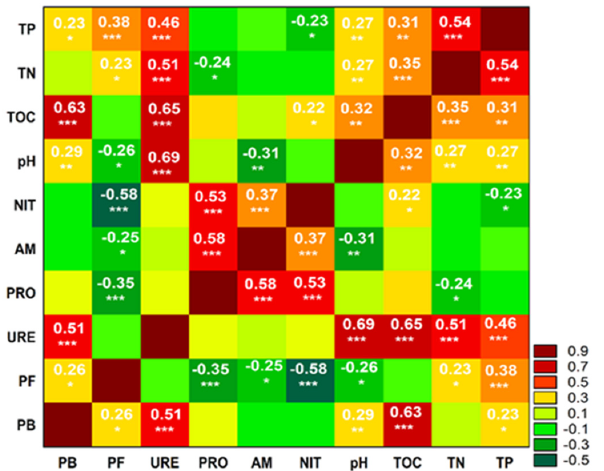
Figure 9. Heatmap displaying the Pearson’s correlation coefficients between soil